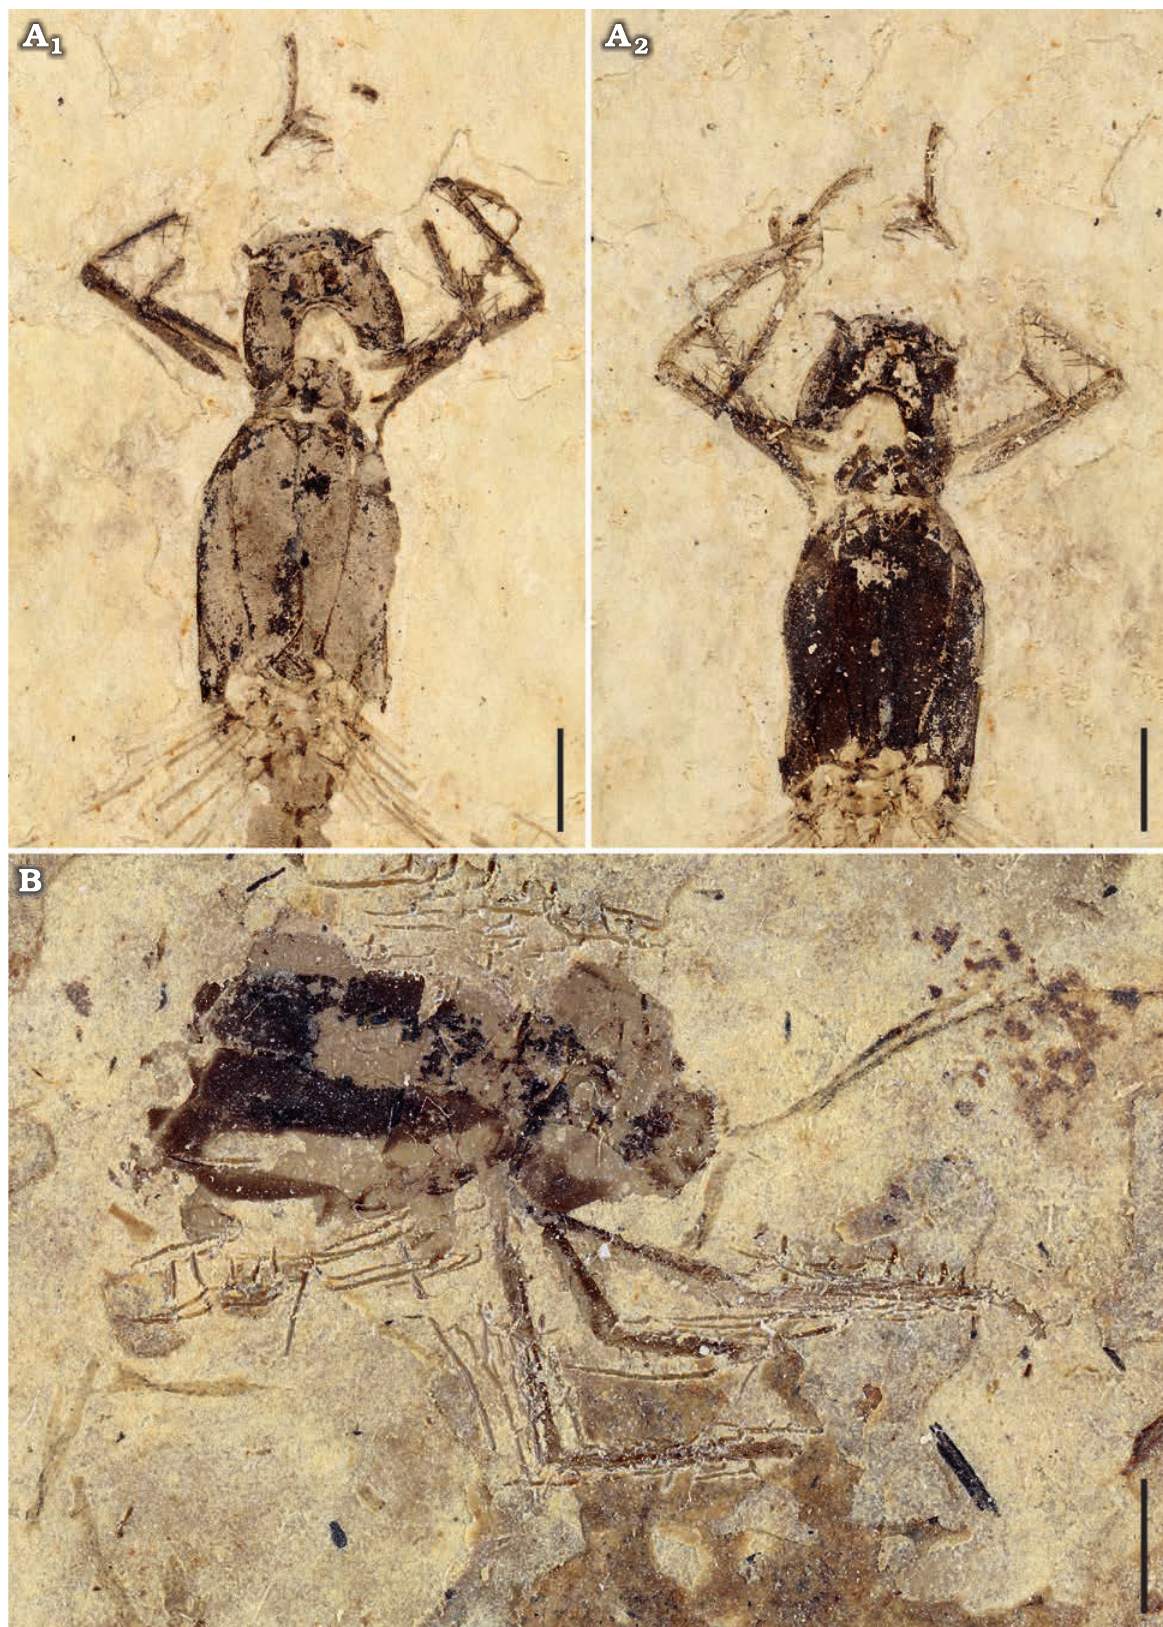
Fig. 11. Zygopteran odonatan Lestes ceresti Nel and Papazian, 1985, from Oligocene, Céreste, France. A . PNRL 2019, imprint (A 1 ) and counterimprint (A 2 ) of head and thorax. B . PNRL 2020, imprint of head and thorax. Scale bars 2